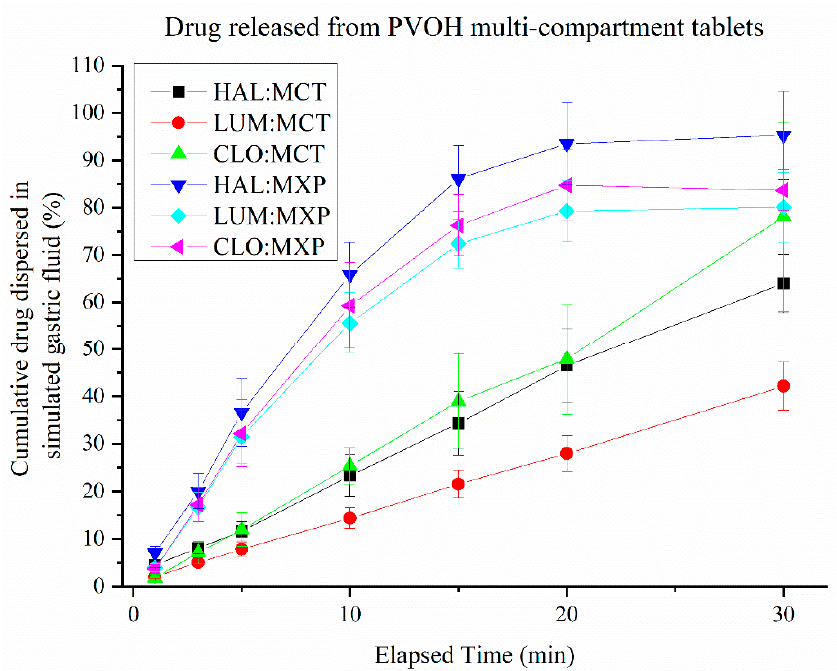
Figure 11. Drug release from multicompartment PVOH-based scaffold tablets (MCT), and mixed drug pellets (MXP), containing HAL-, LUM- and CLO-loaded SMEDDS (error bars = AVG ± STD, n = 4).